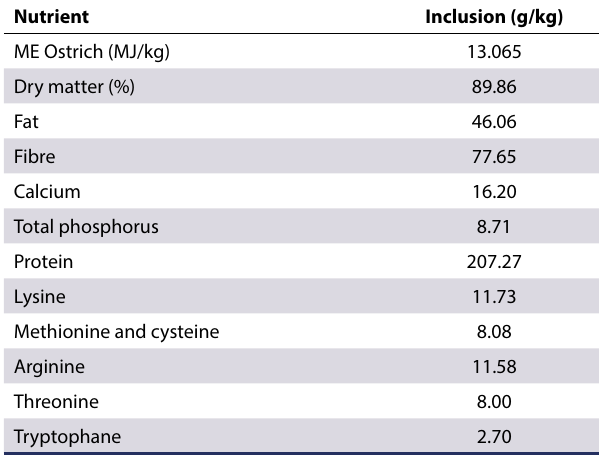
Table IIb: Nutritional composition of the basal starter diet (Brand, 2005) fed during Trial